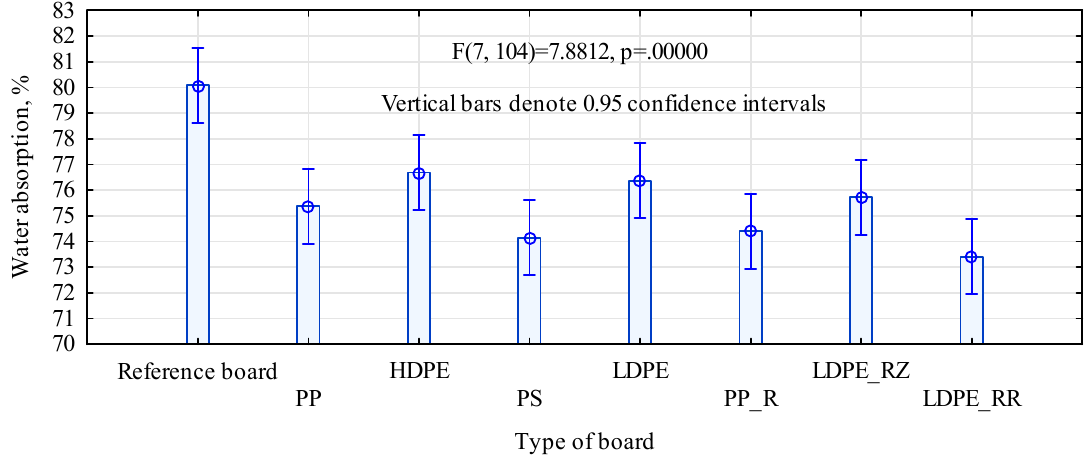
Figure 3. Water absorption in boards made from different materials.